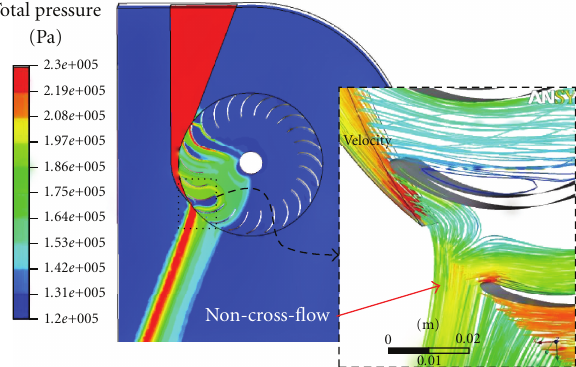
Figure 13: Total pressure contour at midspan of domain nozzle runner casing for runner speed 600 rpm.